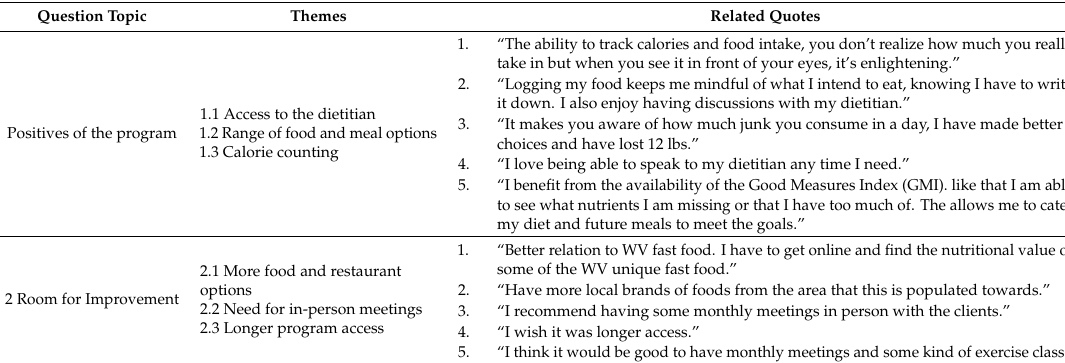
Table 4. Qualitative themes with associated quotes from